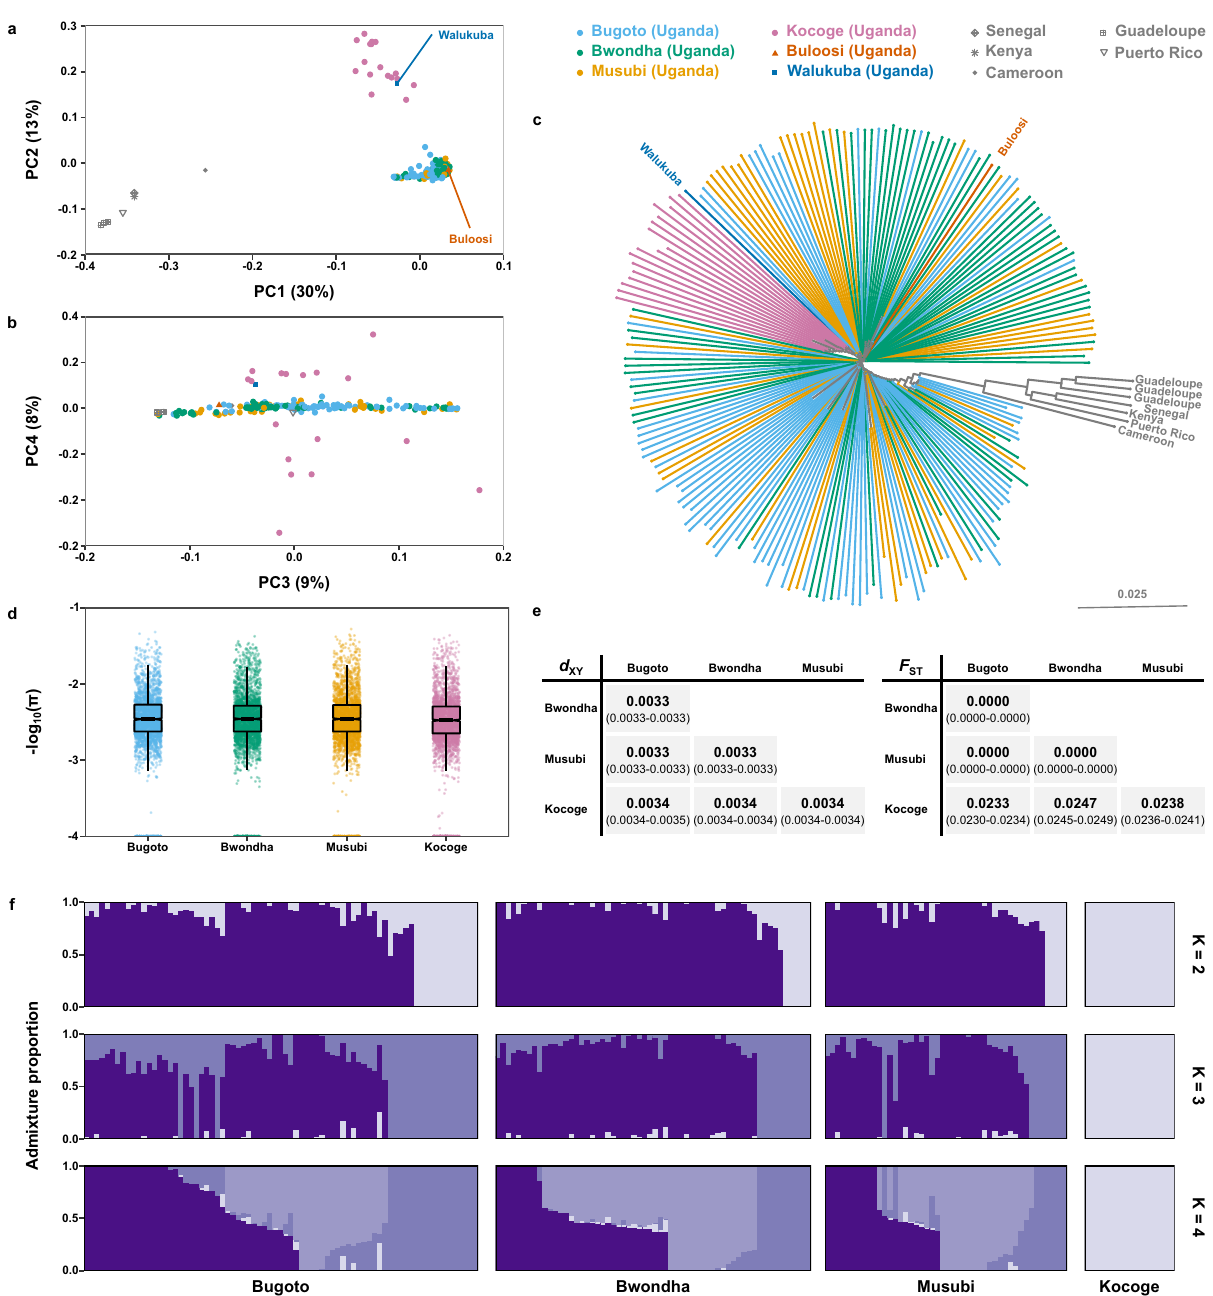
Fig. 2 Schistosoma mansoni population structure. Principal component analysis (PCA) of genetic differentiation within and between the 198 S. mansoni isolates produced in the present study, plus nine previously published samples from Uganda and elsewhere. a Principal components 1 and 2 and b components 3 and 4 with the fi rst four principal components accounting for 60% of the total variance. Points represent samples from three schools Mayuge district (Uganda), Bugoto (light blue), Bwonda (green) and Musubi (yellow) and one school from Tororo district, Kocoge (pink). We included nine additional previously published samples, one sample was from Buloosi school (orange) ~40 km east of Mayuge district, a second sample was from Walukuba school (dark blue) near Lake Albert and the remaining samples (grey) were from Guadeloupe, Senegal, Kenya, Puerto Rico and Cameroon. c Midpoint rooted neighbour-joining phylogeny showing the relatedness between samples, branches are coloured based on the school or region where sample collection occurred. d Autosomal nucleotide diversity ( π ) values, calculated as the mean of non-overlapping 5 kb windows for each school population: Bugoto ( n = 75 miracidia), Bwondha ( n = 60), Musubi ( n = 46) and Kocoge ( n = 17). For all boxplots, the central line indicates the median, the top and bottom edges of the box indicate the 25th and 75th percentiles, respectively. The maximum whisker lengths are speci fi ed as 1.5 times the interquartile range. e Pairwise comparisons of fi xation index ( F ST ) and absolute divergence ( d XY ) between each school population. Both statistics were calculated using autosomal variants in non-overlapping 5 kb windows using the same sample sizes as ( d ). Median values for each comparison are shown in bold, numbers in parentheses represent the 95% bootstrap con fi dence intervals around the median. f ADMIXTURE plots illustrating the population structure, assuming 2 – 4 populations are present ( K ), using 10-fold cross-validation and standard error estimation with 250 bootstraps. Y -axis values show admixture proportions for different values of K ( K = 2 – 4), each shade of purple indicates a different